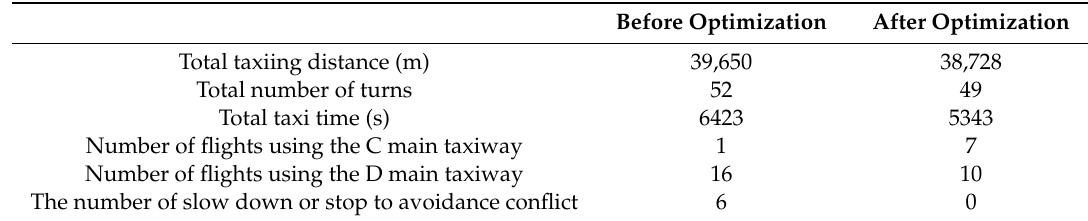
Table 4. Comparison of important data before and after aircraft path optimization.